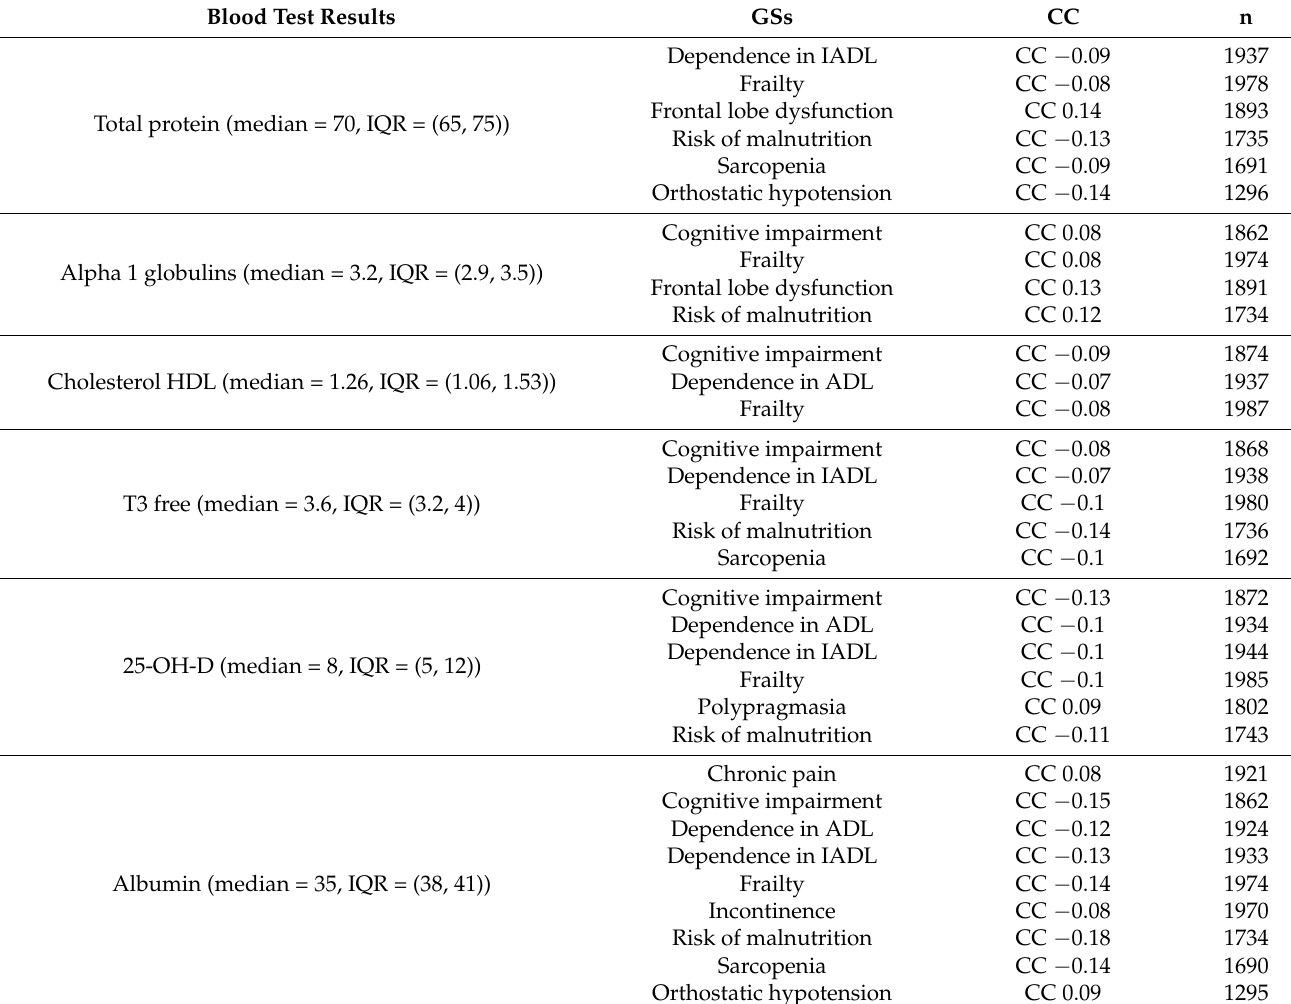
Table 3. Assessment of the association between the laboratory test results, GSs and presence of ADDs (only significant, p -value <